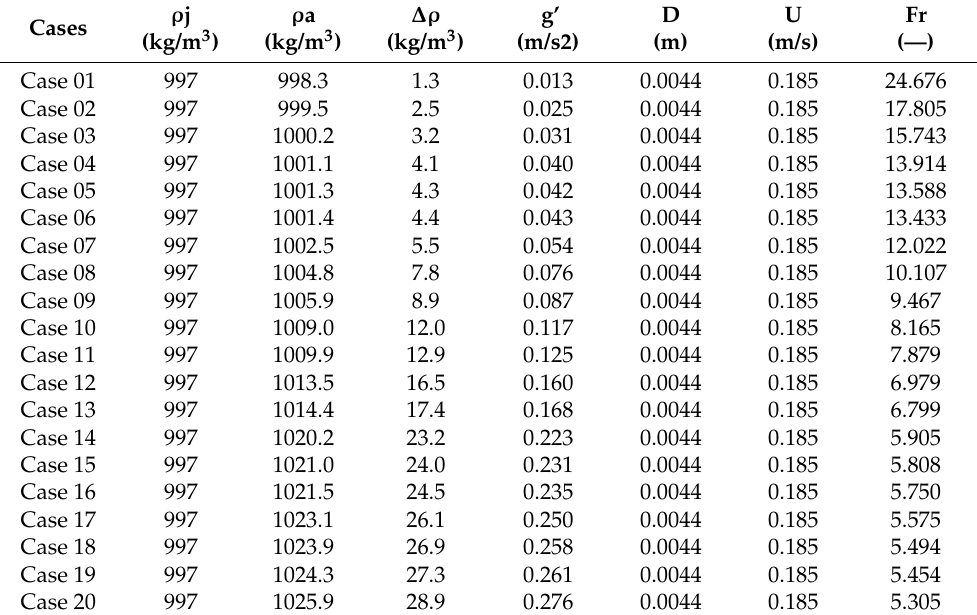
Table 2. Parameters for the additional